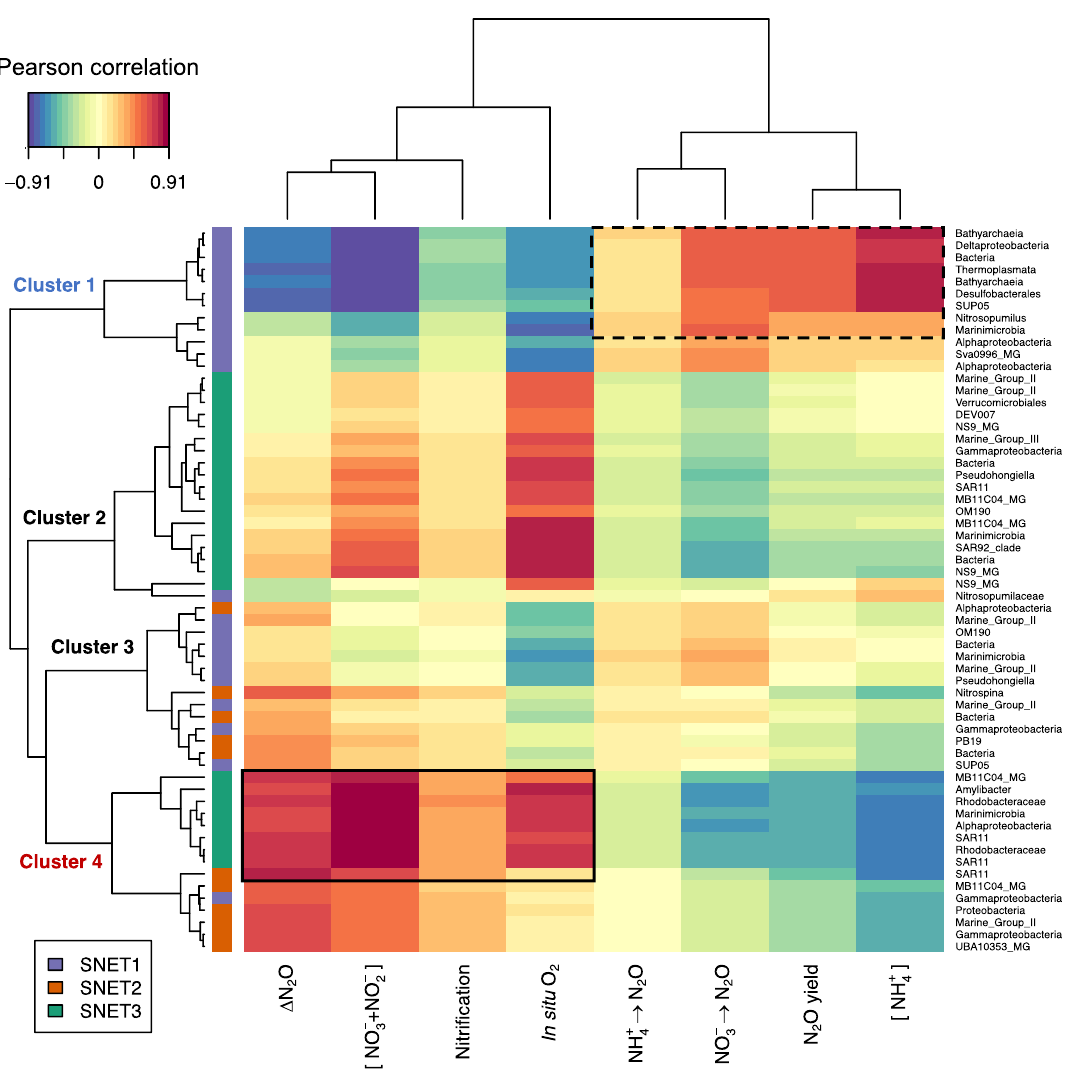
Fig. 5 Relationships between prokaryotic amplicon sequence variants (ASVs), relevant environmental variables, and process rates. N 2 O production rates from NH 4 + oxidation and NO 3 − reduction are symbolized by black arrows. Pairwise correlation coef fi cients between ASVs and sample traits were calculated using a two-component sPLS regression model and are presented as a clustered heatmap. Taxa with correlations to nitri fi cation rates >0.30 are indicated by solid black lines and taxa with correlations to N 2 O production from NO 3 − reduction >0.50 are indicated by dashed lines. Hierarchical clustering of variables was achieved using a complete Euclidean distance method. ASV subnetwork assignments determined through WGCNA are indicated by colored rectangles on the vertical axis dendrogram. Taxonomic labels correspond to the lowest level of classi fi cation determined for each ASV through alignment with the SILVA